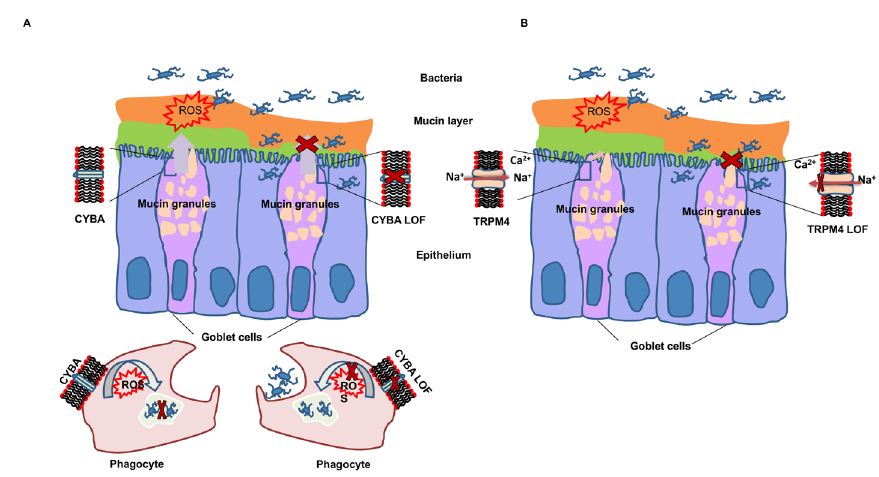
Figure 6. Schematic presentation of the suggested consequences of CYBA and TRPM4 variants on colonic mucin layer integrity. ( A ) The loss-of-function variant in CYBA leads to decreased ROS production and promotes CRC by faltering defense against intestinal bacteria at colonic epithelium and by suppressing bacterial killing by intestinal phagocytes. ( B ) The loss-of-function variant in TRPM4 leads to decreased mucus secretion due to inactivation of the TRPM4 channel, potentially leading to mucus-layer disruption with bacterial penetration into the mucin-protected epithelium, inflammation and colorectal cancer. The function of the wild-type CYBA and TRPM4 is shown in the left goblet cell; the function of CYBA and TRPM4 after the loss-of-function (LOF) variant is shown in the right goblet